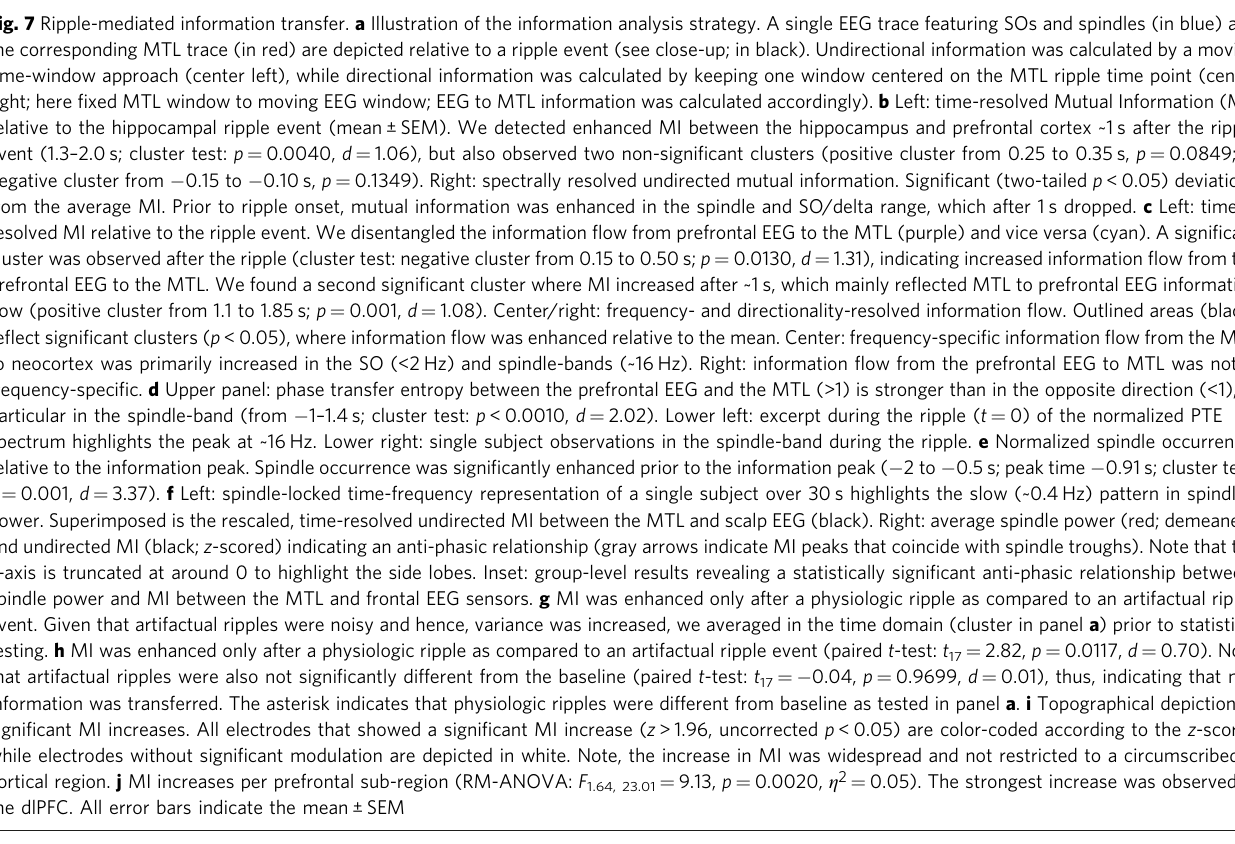
Fig. 7 Ripple-mediated information transfer. a Illustration of the information analysis strategy. A single EEG trace featuring SOs and spindles (in blue) and the corresponding MTL trace (in red) are depicted relative to a ripple event (see close-up; in black). Undirectional information was calculated by a moving time-window approach (center left), while directional information was calculated by keeping one window centered on the MTL ripple time point (center right; here fi xed MTL window to moving EEG window; EEG to MTL information was calculated accordingly). b Left: time-resolved Mutual Information (MI) relative to the hippocampal ripple event (mean ± SEM). We detected enhanced MI between the hippocampus and prefrontal cortex ~1 s after the ripple event (1.3 – 2.0 s; cluster test: p = 0.0040, d = 1.06), but also observed two non-signi fi cant clusters (positive cluster from 0.25 to 0.35 s, p = 0.0849; negative cluster from − 0.15 to − 0.10 s, p = 0.1349). Right: spectrally resolved undirected mutual information. Signi fi cant (two-tailed p < 0.05) deviations from the average MI. Prior to ripple onset, mutual information was enhanced in the spindle and SO/delta range, which after 1 s dropped. c Left: time- resolved MI relative to the ripple event. We disentangled the information fl ow from prefrontal EEG to the MTL (purple) and vice versa (cyan). A signi fi cant cluster was observed after the ripple (cluster test: negative cluster from 0.15 to 0.50 s; p = 0.0130, d = 1.31), indicating increased information fl ow from the prefrontal EEG to the MTL. We found a second signi fi cant cluster where MI increased after ~1 s, which mainly re fl ected MTL to prefrontal EEG information fl ow (positive cluster from 1.1 to 1.85 s; p = 0.001, d = 1.08). Center/right: frequency- and directionality-resolved information fl ow. Outlined areas (black) re fl ect signi fi cant clusters ( p < 0.05), where information fl ow was enhanced relative to the mean. Center: frequency-speci fi c information fl ow from the MTL to neocortex was primarily increased in the SO (<2 Hz) and spindle-bands (~16 Hz). Right: information fl ow from the prefrontal EEG to MTL was not frequency-speci fi c. d Upper panel: phase transfer entropy between the prefrontal EEG and the MTL (>1) is stronger than in the opposite direction (<1), in particular in the spindle-band (from − 1 – 1.4 s; cluster test: p < 0.0010, d = 2.02). Lower left: excerpt during the ripple ( t = 0) of the normalized PTE spectrum highlights the peak at ~16 Hz. Lower right: single subject observations in the spindle-band during the ripple. e Normalized spindle occurrence relative to the information peak. Spindle occurrence was signi fi cantly enhanced prior to the information peak ( − 2 to − 0.5 s; peak time − 0.91 s; cluster test: p = 0.001, d = 3.37). f Left: spindle-locked time-frequency representation of a single subject over 30 s highlights the slow (~0.4 Hz) pattern in spindle power. Superimposed is the rescaled, time-resolved undirected MI between the MTL and scalp EEG (black). Right: average spindle power (red; demeaned) and undirected MI (black; z -scored) indicating an anti-phasic relationship (gray arrows indicate MI peaks that coincide with spindle troughs). Note that the y-axis is truncated at around 0 to highlight the side lobes. Inset: group-level results revealing a statistically signi fi cant anti-phasic relationship between spindle power and MI between the MTL and frontal EEG sensors. g MI was enhanced only after a physiologic ripple as compared to an artifactual ripple event. Given that artifactual ripples were noisy and hence, variance was increased, we averaged in the time domain (cluster in panel a ) prior to statistical testing. h MI was enhanced only after a physiologic ripple as compared to an artifactual ripple event (paired t -test: t 17 = 2.82, p = 0.0117, d = 0.70). Note that artifactual ripples were also not signi fi cantly different from the baseline (paired t -test: t 17 = − 0.04, p = 0.9699, d = 0.01), thus, indicating that no information was transferred. The asterisk indicates that physiologic ripples were different from baseline as tested in panel a . i Topographical depiction of signi fi cant MI increases. All electrodes that showed a signi fi cant MI increase ( z > 1.96, uncorrected p < 0.05) are color-coded according to the z -score, while electrodes without signi fi cant modulation are depicted in white. Note, the increase in MI was widespread and not restricted to a circumscribed cortical region. j MI increases per prefrontal sub-region (RM-ANOVA: F 1.64, 23.01 = 9.13, p = 0.0020, η 2 = 0.05). The strongest increase was observed in the dlPFC. All error bars indicate the mean ±